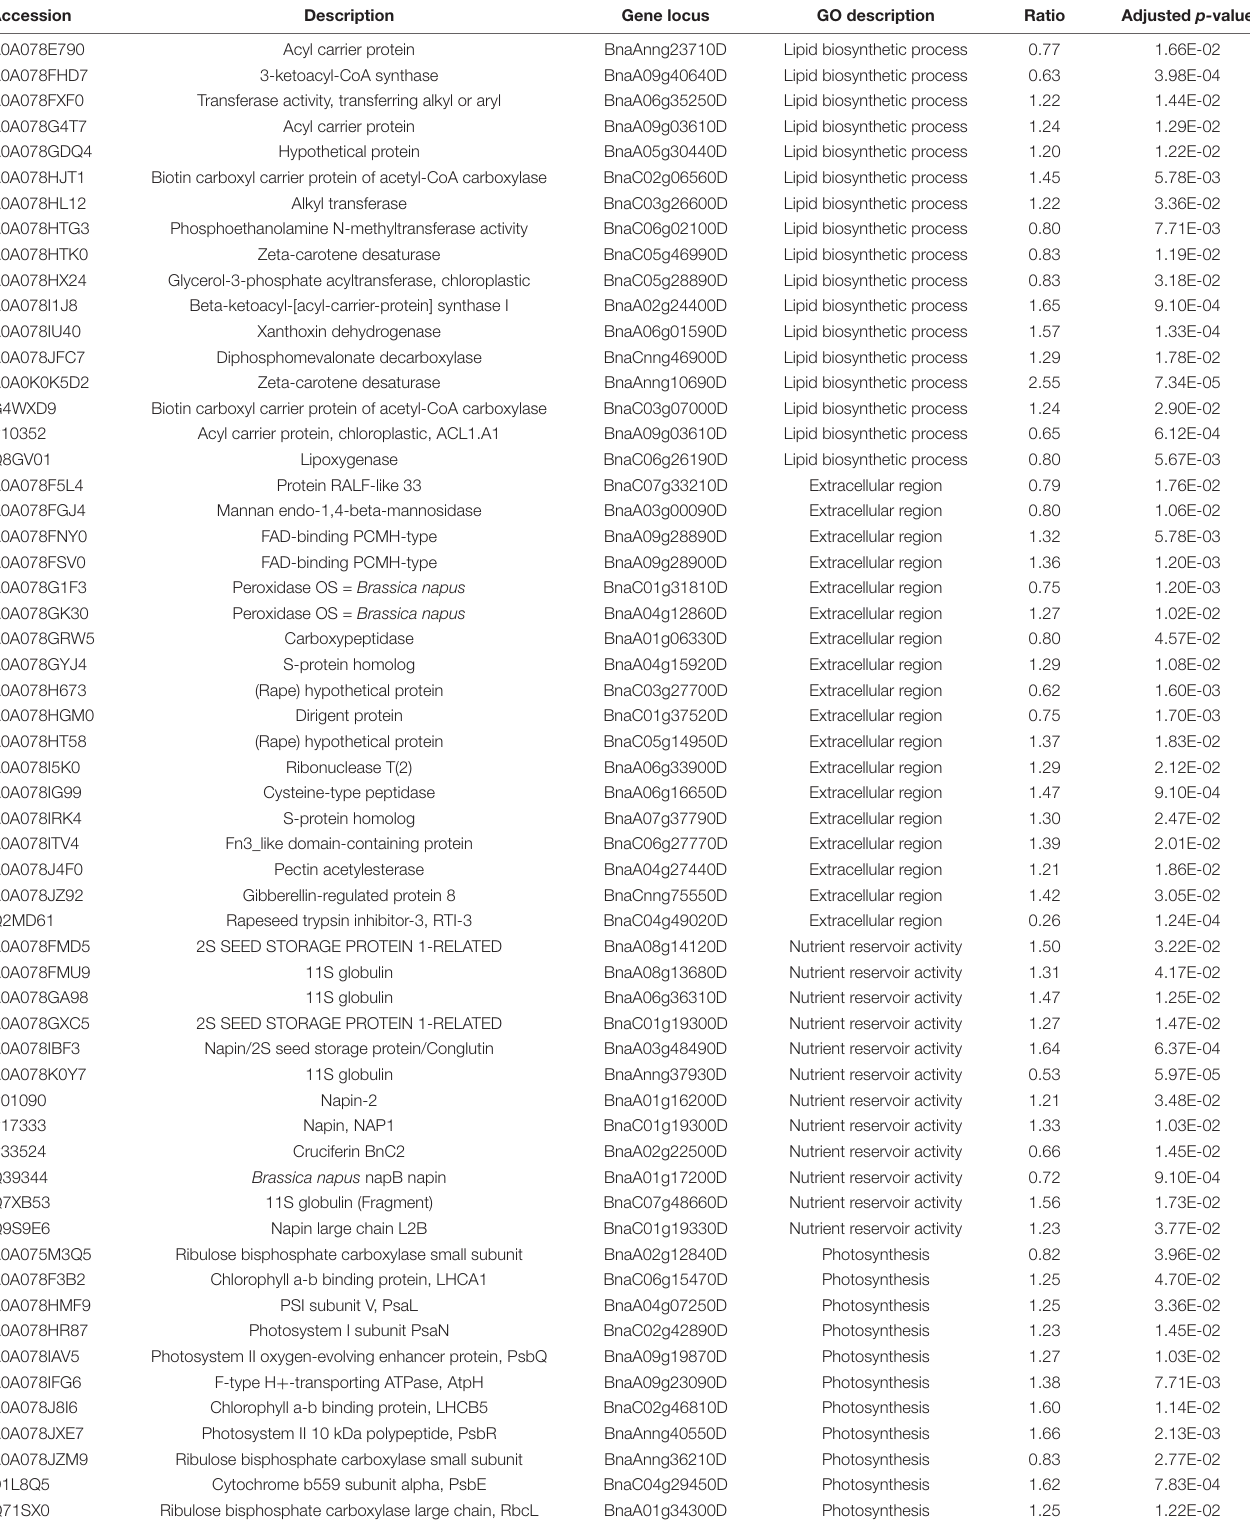
TABLE 1 | Selected DAPs in immature seeds of 35DAA between HOCL and